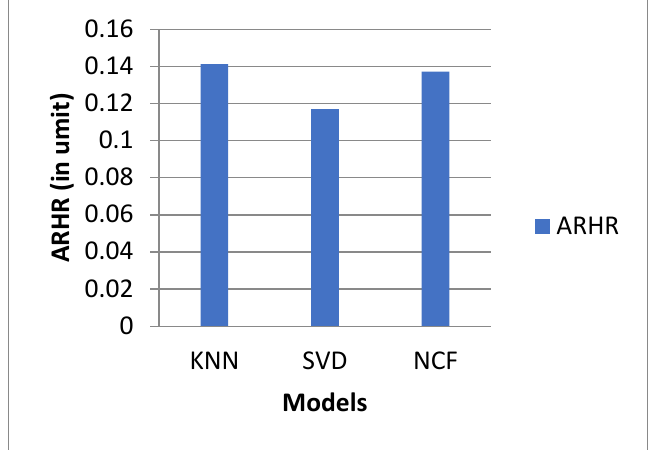
Figure 11. Performance results of different models in terms of ARHR in 70:30 training–testing scenario.